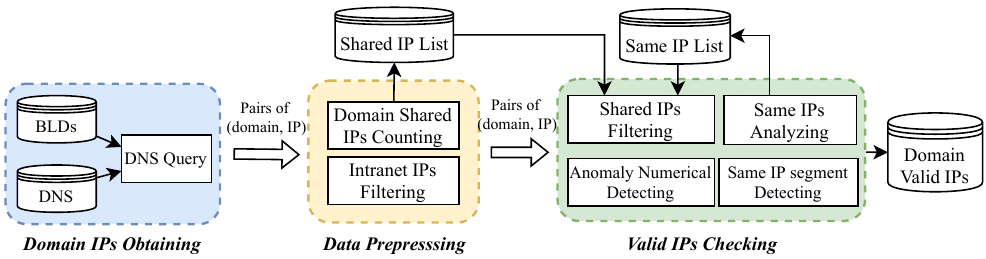
Figure 21. The system to identify valid IPs for blocked domain